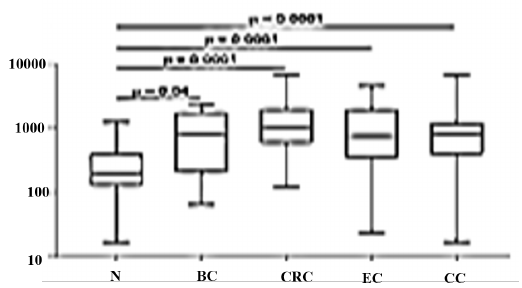
Fig. 3. Validation of combined plasmid mut miR-145 and miR-223 by multiple comparative assay system: Accuracy of this RT method was checked for normal and other cancers relative to breast